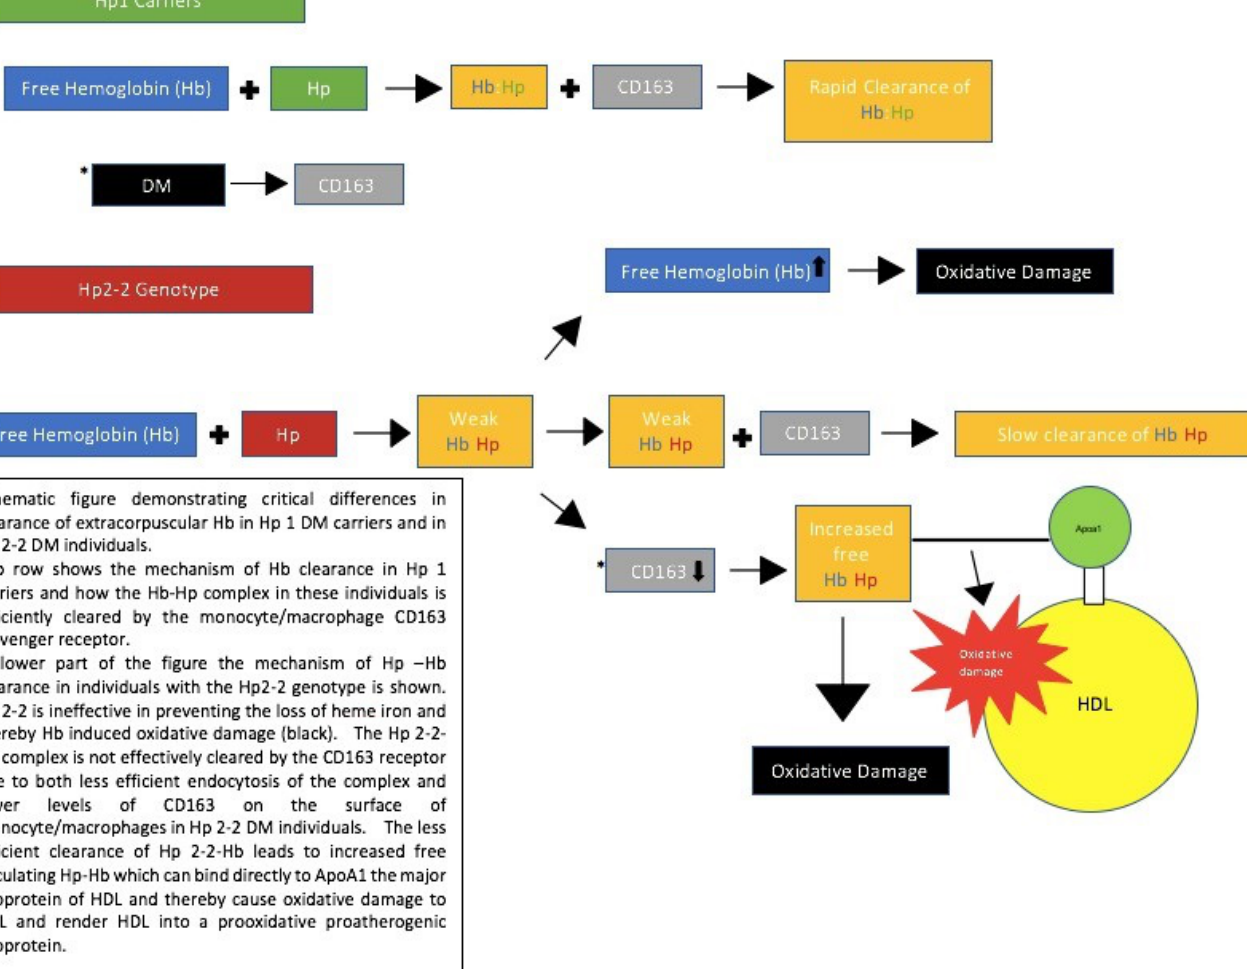
Figure 1. Demonstration of differences in the clearance of extracorpuscular hemoglobin. Hp, haptoglobin, Hb, hemoglobin, DM, diabetes mellitus, HDL, high-density lipoproteins